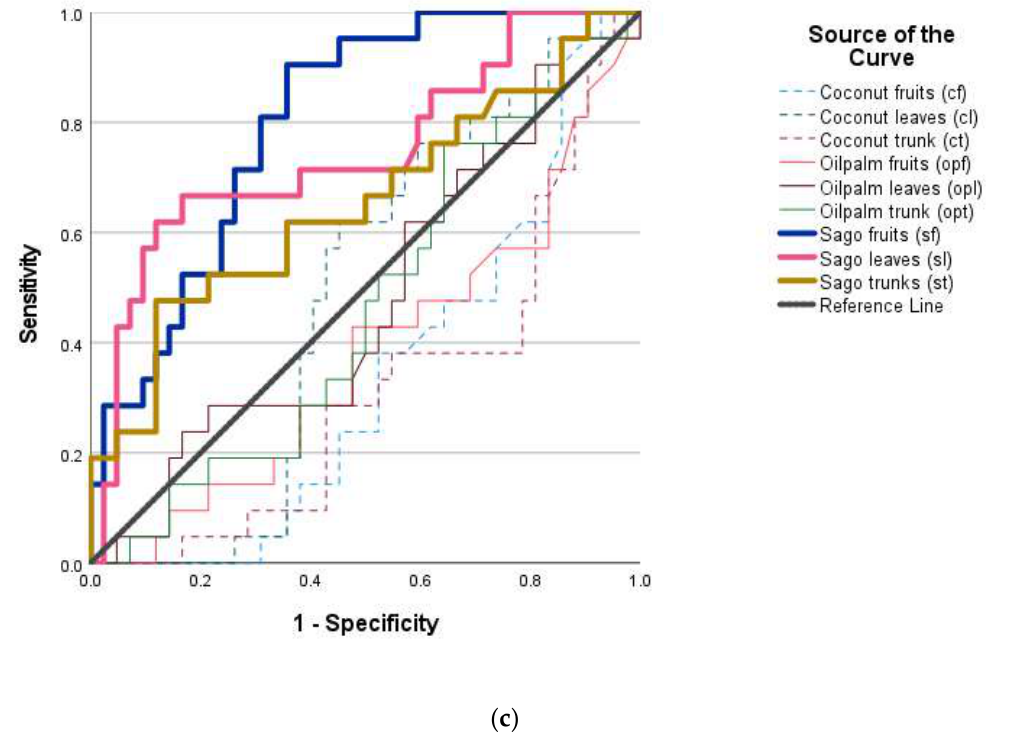
Figure 12. ( a ) ROC curve of the AlexNet. ( b ) ROC curve of the SqueezeNet. ( c ) ROC curve of the ResNet50.